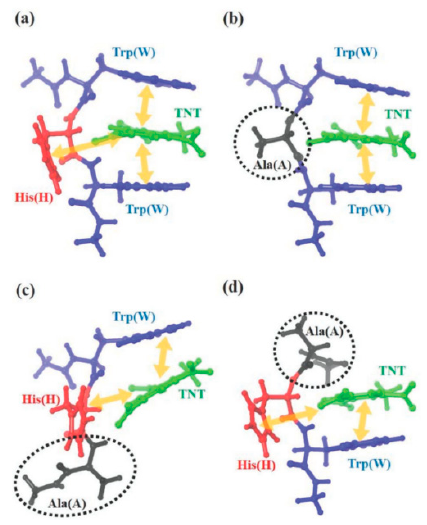
Figure 13. The stable constructions of TNT-specific peptides and their reactivity (red: histidine, blue: tryptophan, black: alanine, green: TNT, yellow, and arrow: π - π interaction). ( a ) WHW–TNT, ( b ) WAW–TNT, ( c ) WHA–TNT, and ( d ) AHW–TNT. Reproduced from [76], with permission from The Royal Society of Chemistry,